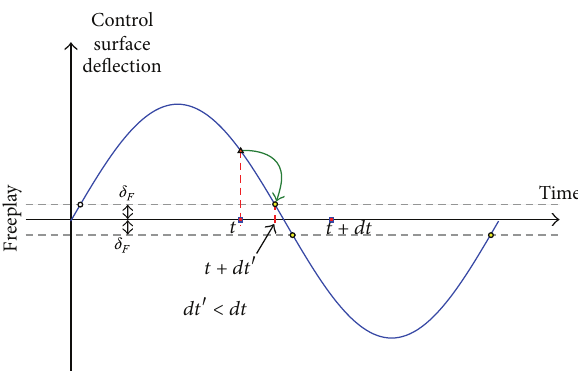
Figure 21: Illustrative scheme of integration process using H´enon’s